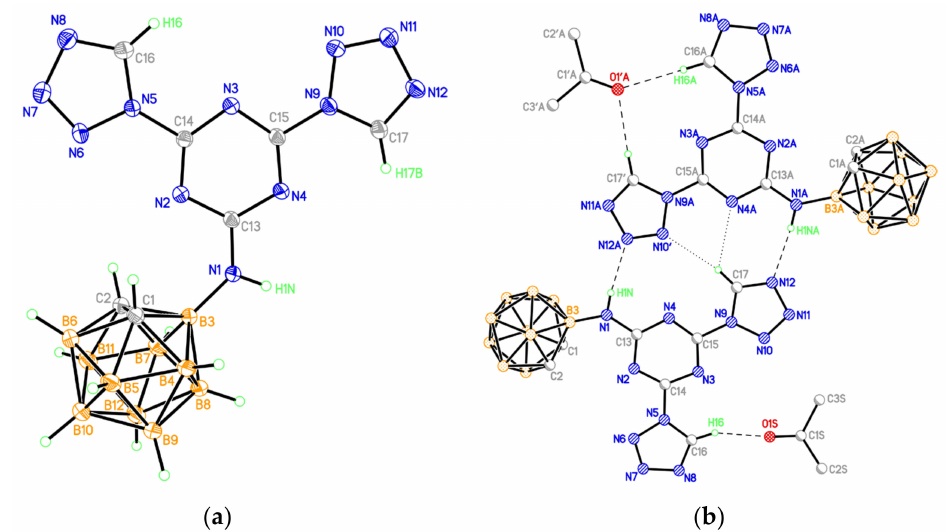
Figure 3. ( a ) Molecular structure of compound 9 (thermal ellipsoids are drawn at the 50% probability level). ( b ) Hydrogen-bonded associate of two conformers of compound 9 (only those hydrogen atoms that are involved in hydrogen bonds are shown).